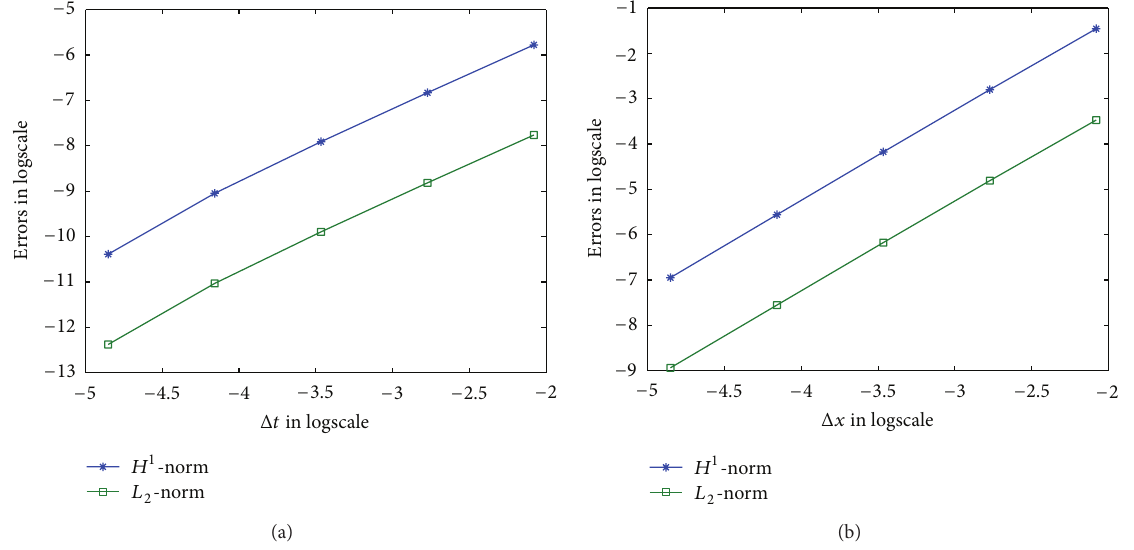
Figure 2: 𝐻 1 -norm and 𝐿 2 -norm of errors for (46) with 𝛼 = 0.5 , 𝛽 = 0.25 , Δ𝑥 = 0.001 (a), and Δ𝑡 = 0.001